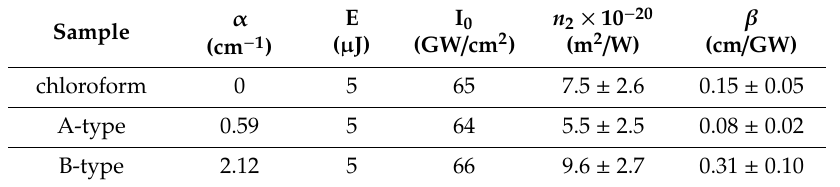
Table 2. Results of the nonlinear optical measurement of ZnO particles in chloroform at 355 nm.